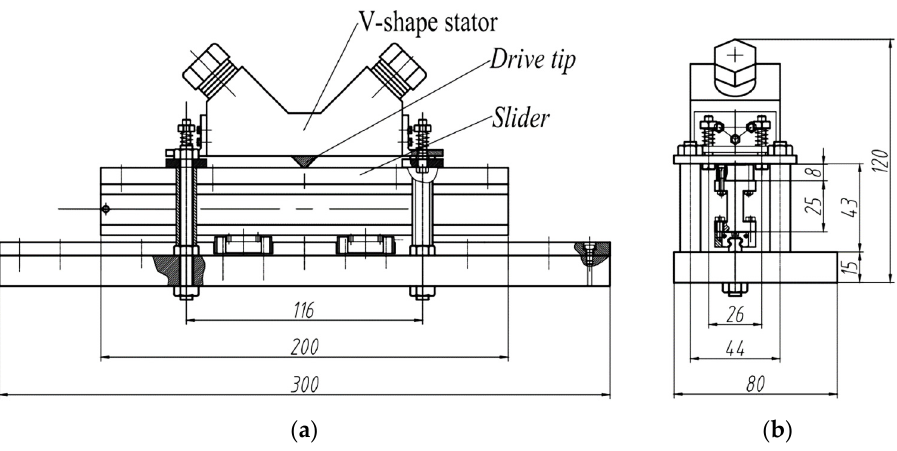
Figure 1. Schematic representation of a wear tester with a V ‐ shaped vibrator: ( a ) front view; and ( b ) lateral view.